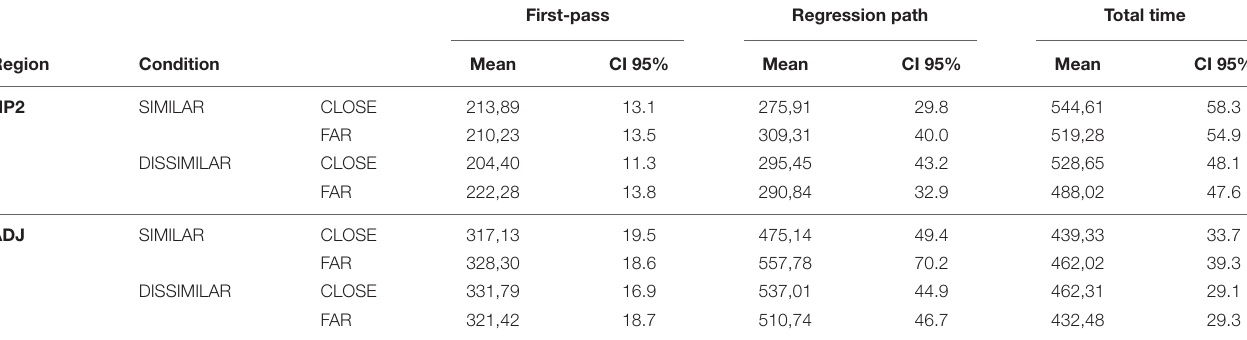
TABLE 2 | Mean reading times in milliseconds and within-participant adjusted 95% confidence intervals (by condition, region and measure) in Experiment 2. First-pass Regression path Total